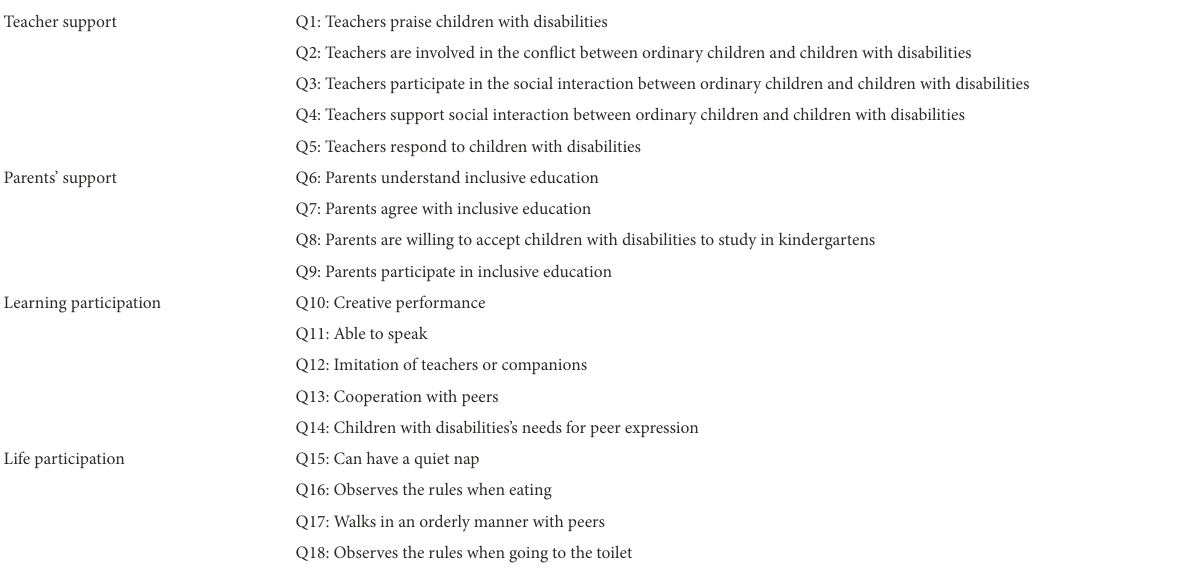
TABLE 9 Items of the questionnaire on the participation of children with disabilities in preschool inclusive education. Teacher